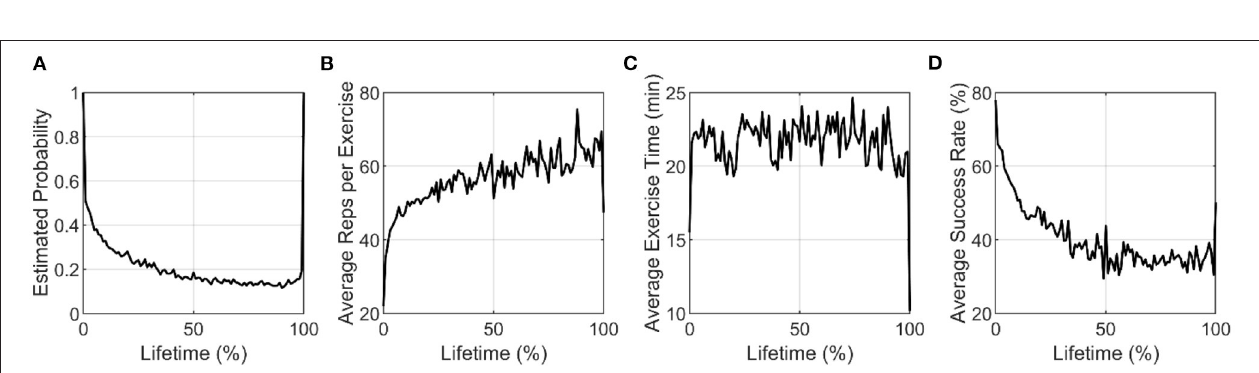
FIGURE 9 | (A) Estimated probability of initiating at least one session, and (B–D) Average activity metrics plotted against percent lifetime for active users only. By our definition of percent lifetimes, all users are active on the first and last ticks of the normalized lifetimes.